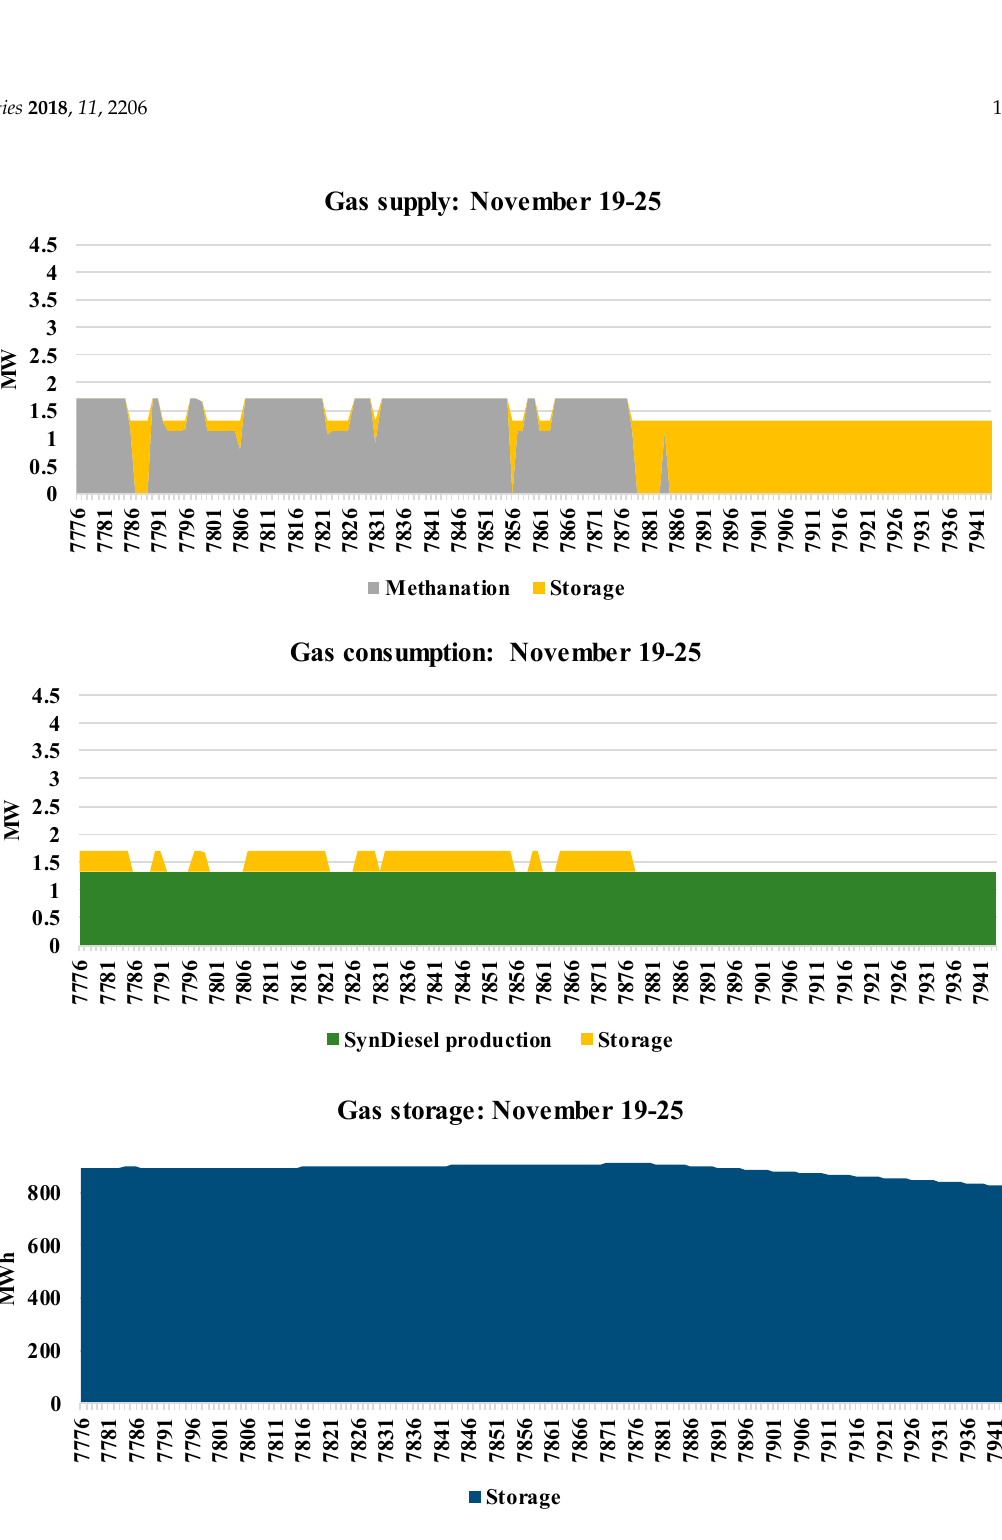
Figure 13. Gas supply ( Top ), consumption ( Centre ), and storage ( Bottom ) for the second study period: 19–25 November. Relatively high levels of variable RE generation at the beginning of the week led to high levels of methane production. This ended later in the week as demands for power were high and variable RE generation was at its lowest. Gas needed for synthetic fuel production came from storage, which declined near the end of the week, but was still at more than 75% capacity.